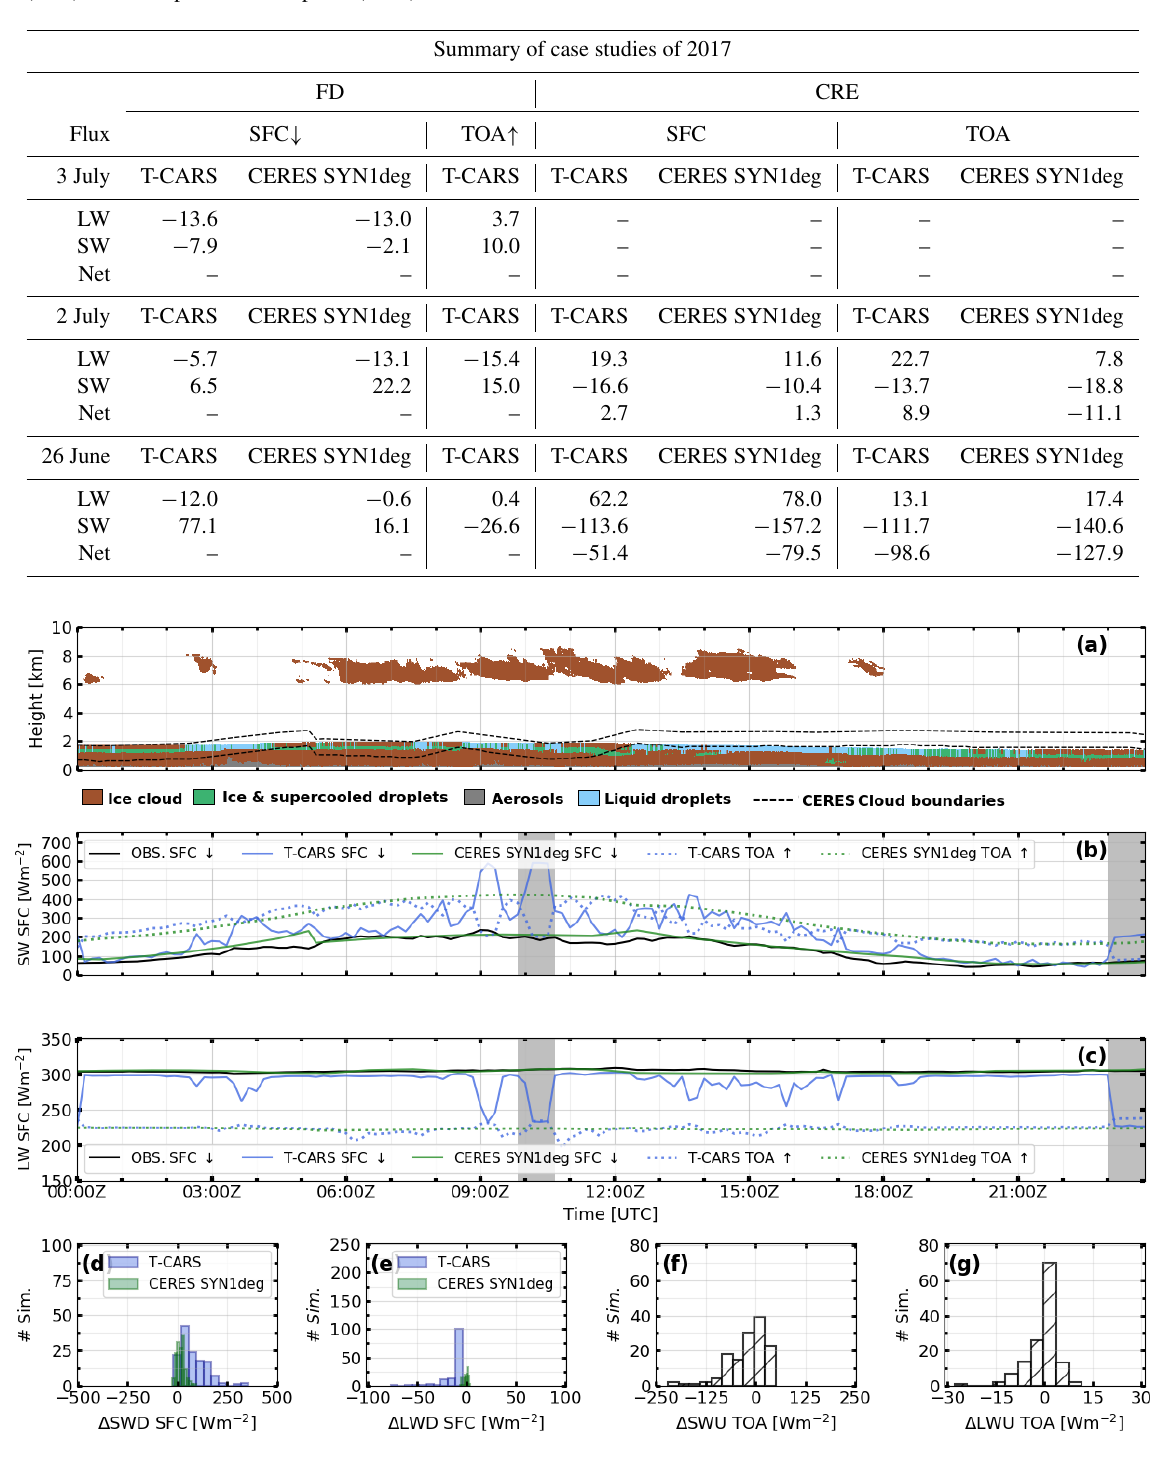
Table 2. Summary of case studies’ results. Values indicate the bias and the cloud radiative effect (CRE) for each case study in Wm − 2 at the surface (SFC) and the top of the atmosphere (TOA).